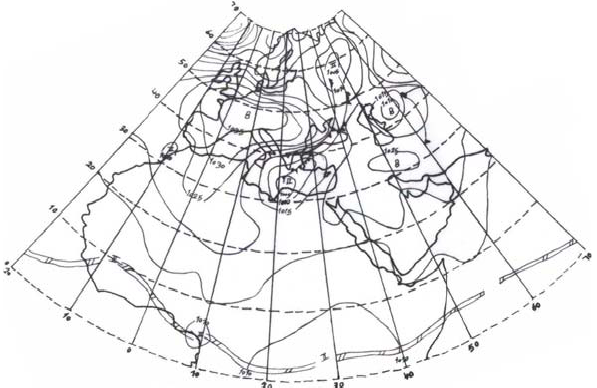
Fig. 4 The pattern of the surface isobars (AAXX) after the rainfall (Type I: 1st December 1986)